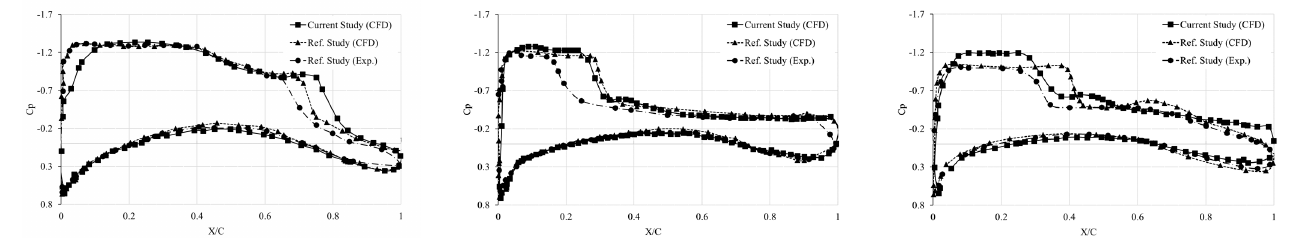
Figure 9. CRM aircraft in cruise flight condition S 1 (M = 0.85 at 44,000 ft) with an angle-of-attack α = 5.5 ◦ . Coefficient of pressure (C p ) around the main wing, as plotted at three relative positions from the root (( left ): η = 0.283; ( center ): η = 0.603; ( right ): η = 0.846). Present results (line) with comparison against the reference CFD (dash) and experiment (dot-dash)